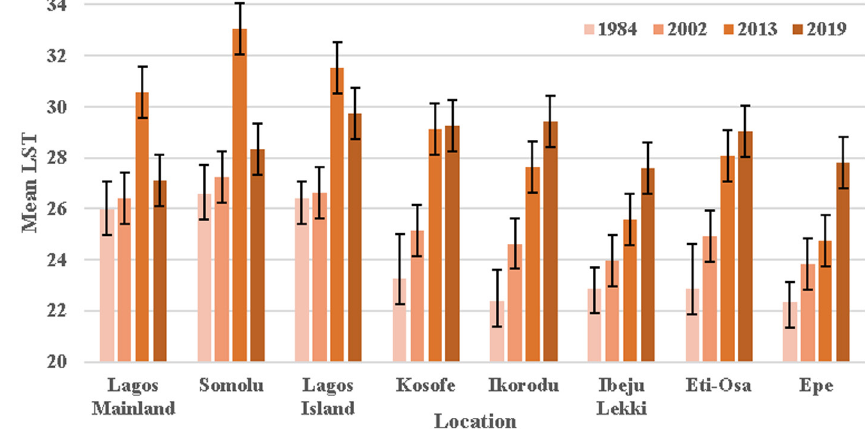
Fig. 8. Mean LSTs (°C) associated with the eight LGAs.